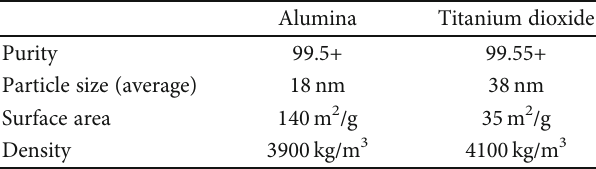
Table 1: Properties of nanoparticles used in the study [35].